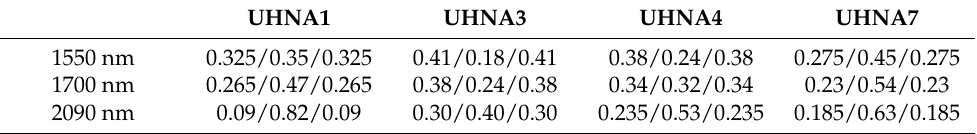
Table 3. Length ratios minimising β 2 through 1-m of cascaded SMF-28/UHNA/SMF-28 fibers.